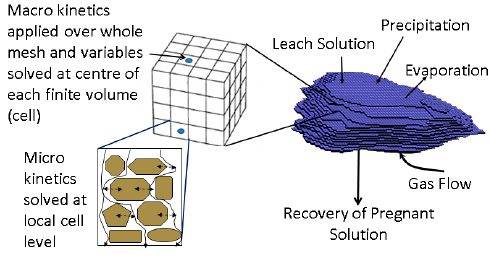
Figure 1. Mesh of heap, macro and micro solution points and boundary conditions.